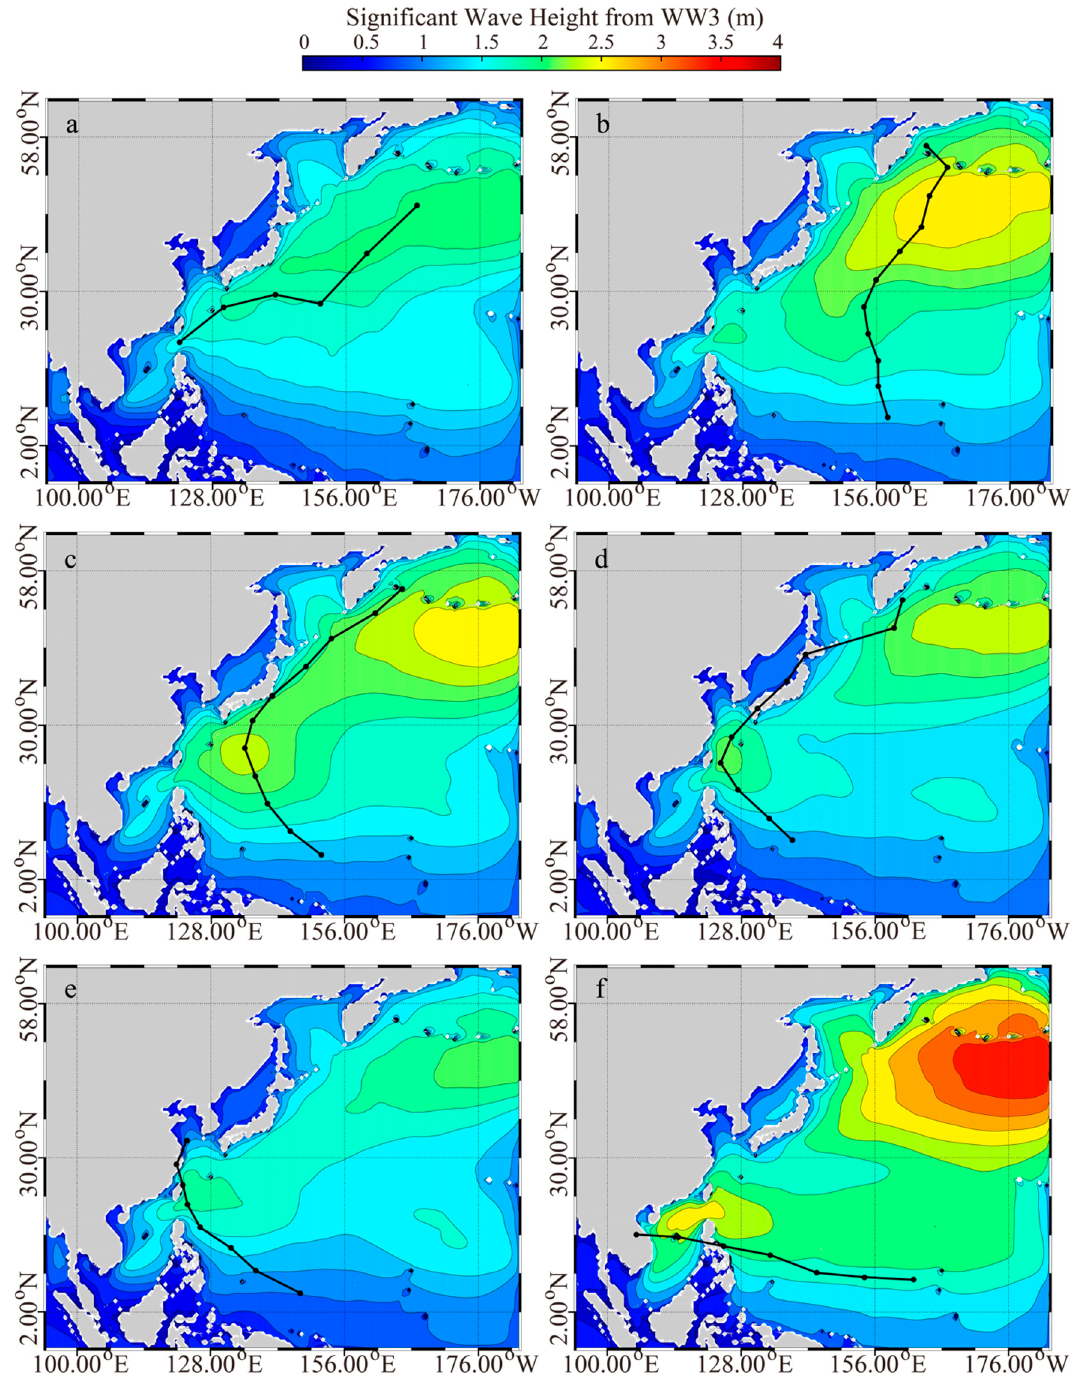
Figure 4. The average result of SWH from the WW3 for each type of typhoon paths from 1998 to 2018, in which the black polylines represent the typical paths for each type of typhoon paths. ( a ) Northeast shift; ( b ) east turn; ( c ) middle turn; ( d ) west turn; ( e ) northwest shift; and ( f ) west